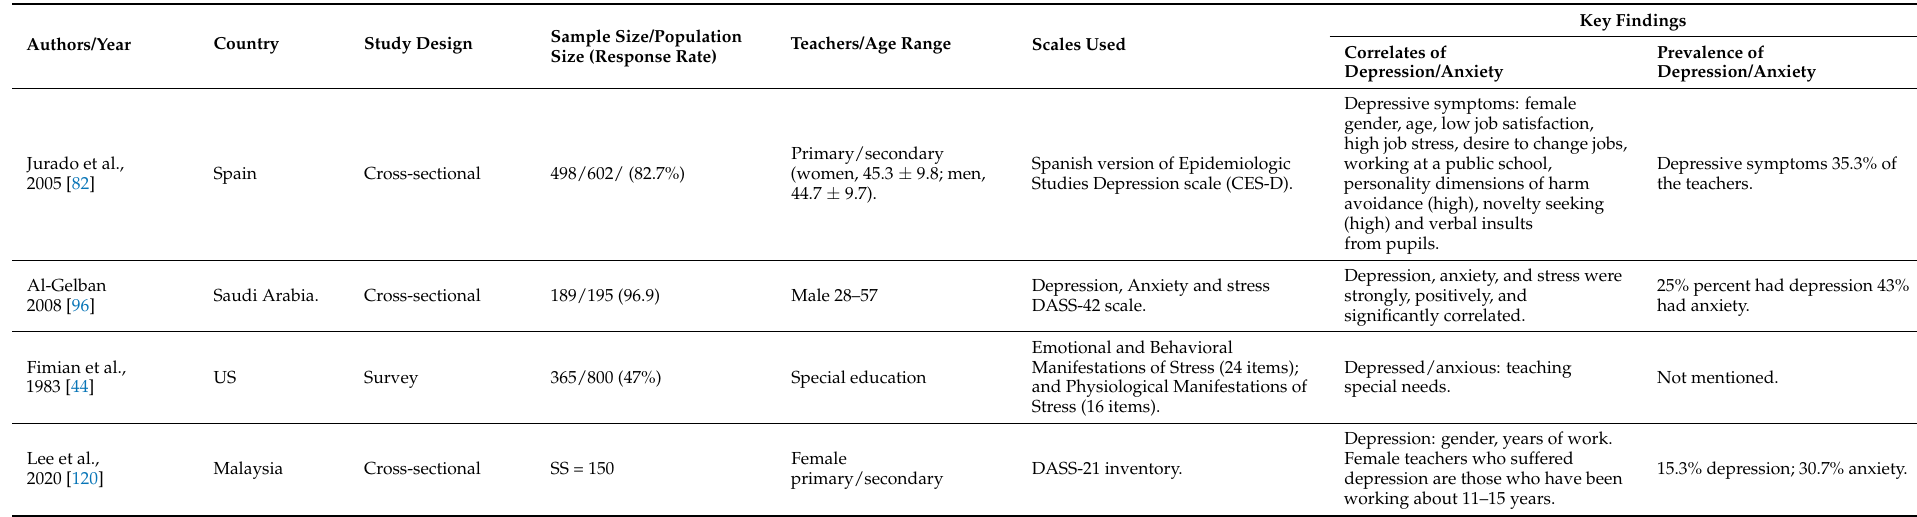
Table A2. Summary of studies with prevalence and correlates of